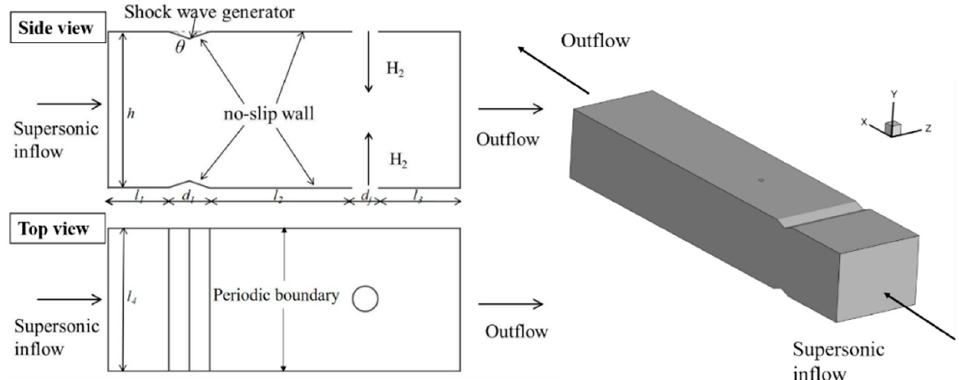
Figure 3. Schematic diagram of computing domain of fuel counter-flow jet.